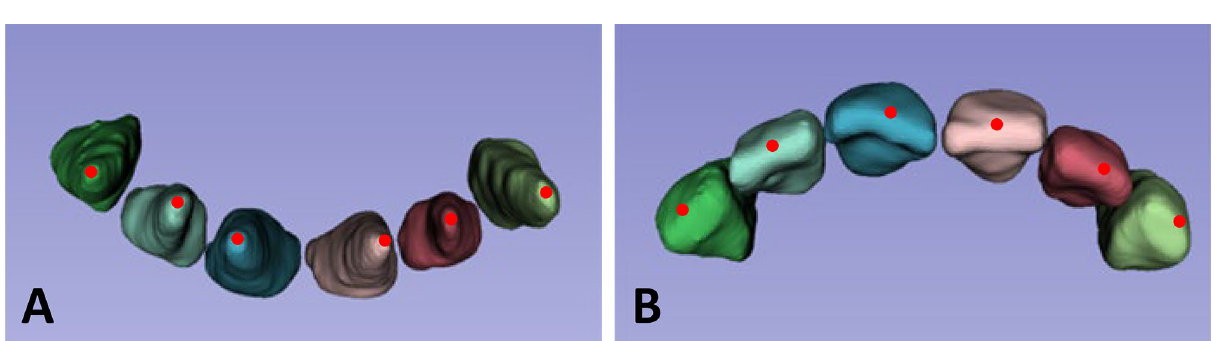
Figure 7. The red dot indicates the apical point ( A ) and the coronal point ( B ) of the long